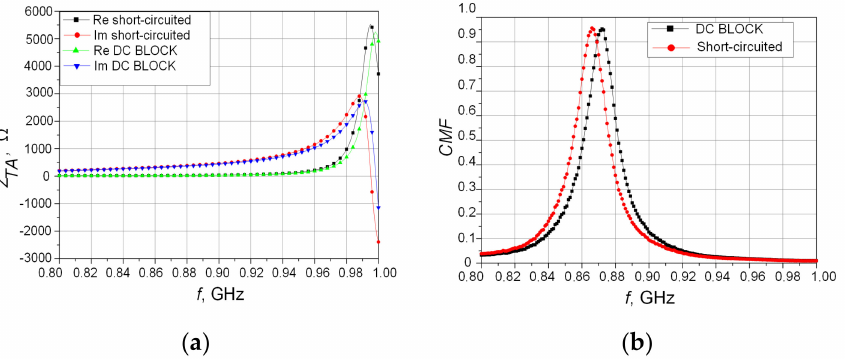
Figure A3. Influence of DC block on RFID antenna parameters: ( a ) Impedance Z TA ; ( b )